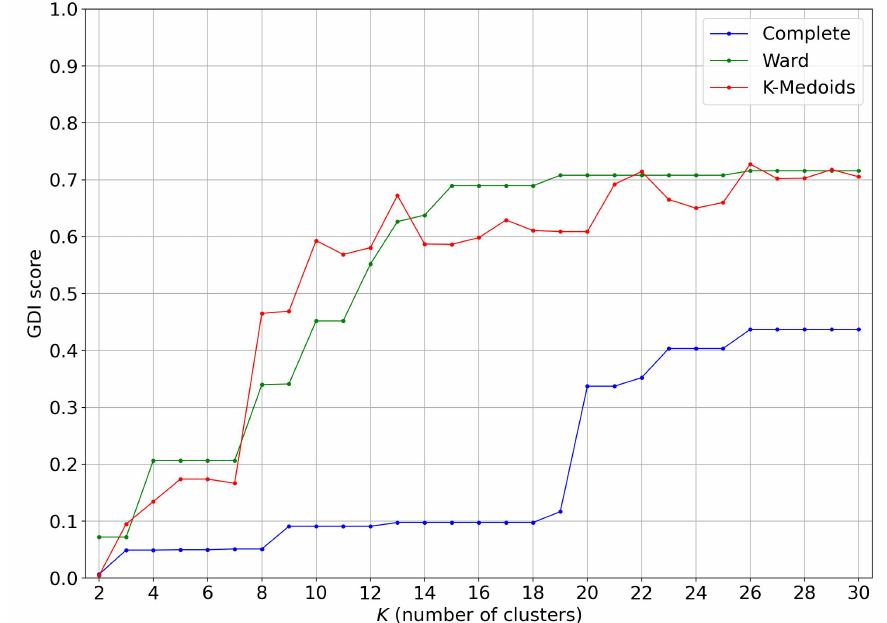
Figure 13. GDI score evolution of various clustering algorithms on the persistence diagrams with Wasserstein